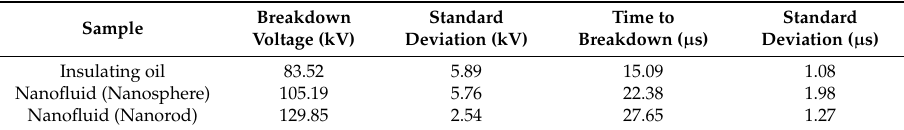
Table 1. Positive breakdown properties of insulating oil and TiO 2 nanofluids.